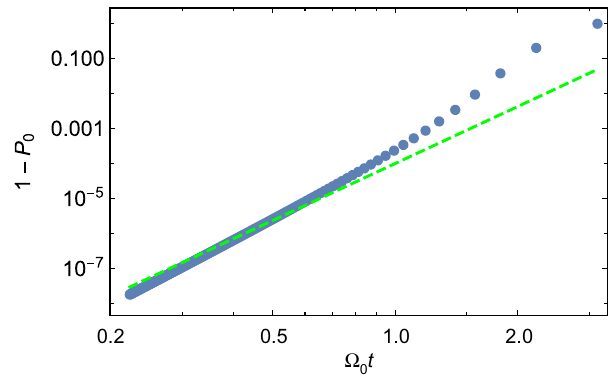
FIG. 4. Usefulness of an ideal, transcoherent field state in cre- ating a second maximally coherent atomic state. Plotted is the failure probability 1 − P 0 of creating a second atomic coher- ent state after having perfectly transferred coherence to a first √ atom over a duration (cid:3) 0 t = π/ n , on a logarithmic scale (blue circles). The failure rates are incredibly small and decrease pre- cipitously with decreasing time and increasing average photon number; for scale we include the power law 10 − 4 ((cid:3) 0 t ) 5.4 (dashed green line).